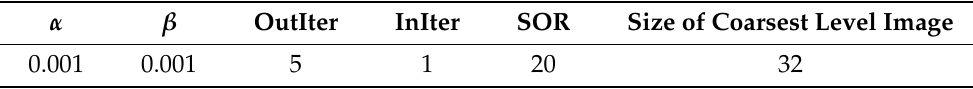
Table 2. The parameters of nonlinear registration.